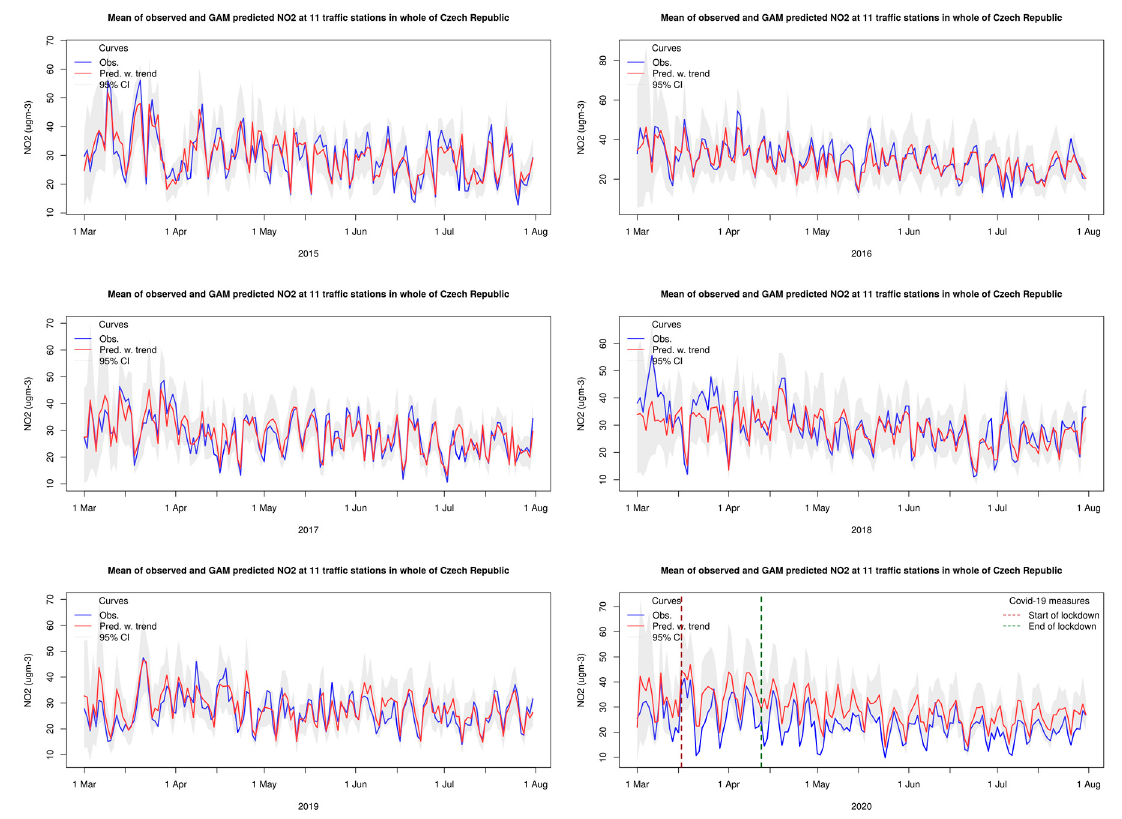
Figure 9. Same as Figure 8 for traffic sites in the Czech